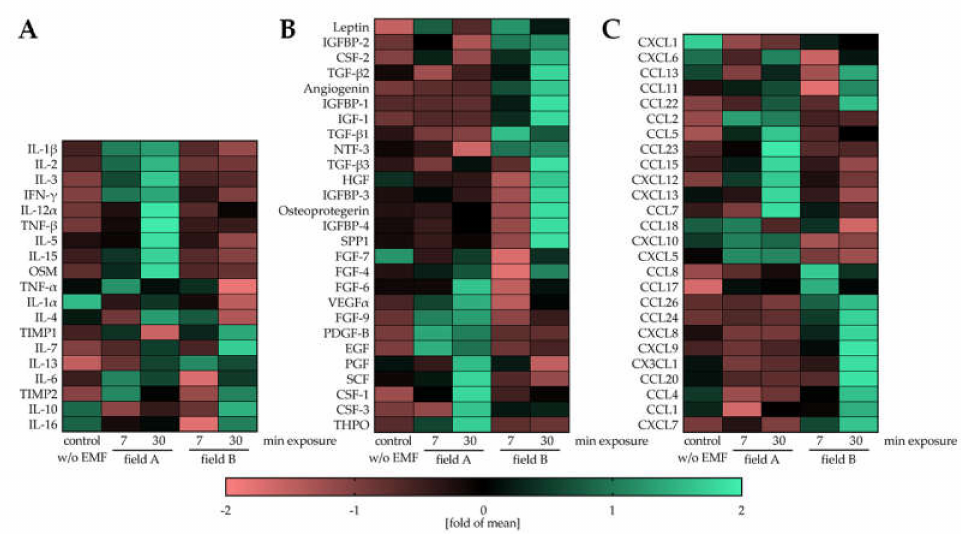
Figure 4. Cytokines, growth factors and chemokines secreted by PBMCs after exposure to the ELF- PEMFs. Freshly isolated PBMCs (N = 5) were stimulated with 200 nM PMA and exposed to the two ELF-PEMF for 7 min or 30 min, respectively. After 24 h, the conditioned medium was collected, pooled and analyzed ( n = 3) for secreted factors using the human Cytokine Array C5 (RayBiotech, Peachtree Corners, GA, USA). Data were normalized with the standard score (z-score) method. Data are presented as heat maps: ( A ) Heat map of cytokines related to immune function and inflammation; ( B ) Heat map of cytokines and growth factors involved in repair and healing processes; and ( C ) Heat map of